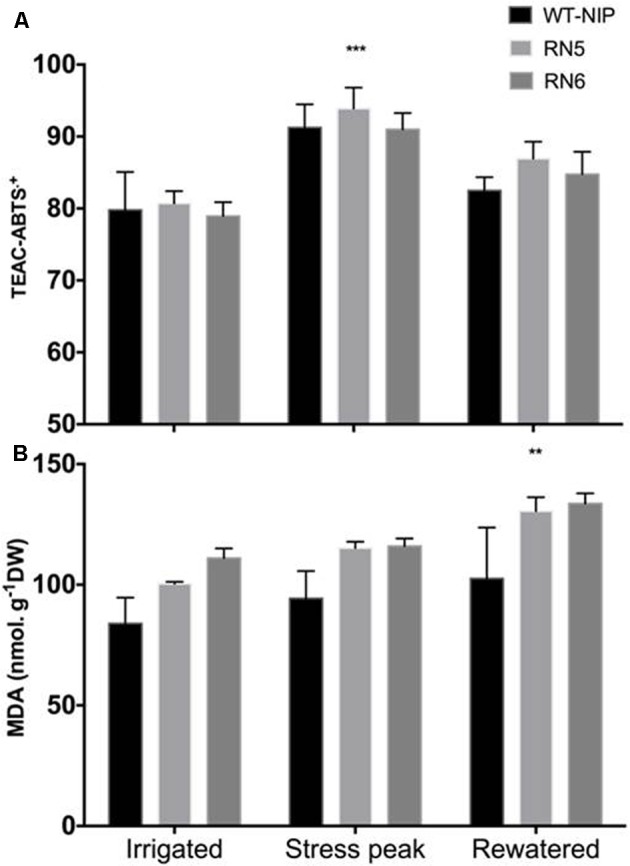
Antioxidant capacity determined by radical cation ABTS∙+ and MDA content under irrigated, drought, and rewatered conditions in Trial 2. (A) Drought stress induced a significant increase (p < 0.001) in the antioxidant capacity, measured by the ABTS assay. No significant differences were detected among lines. (B) A significant increase in MDA (p < 0.01) was measured in all lines after rewatering. Significance level ∗∗p < 0.01, ∗∗∗p < 0.001.